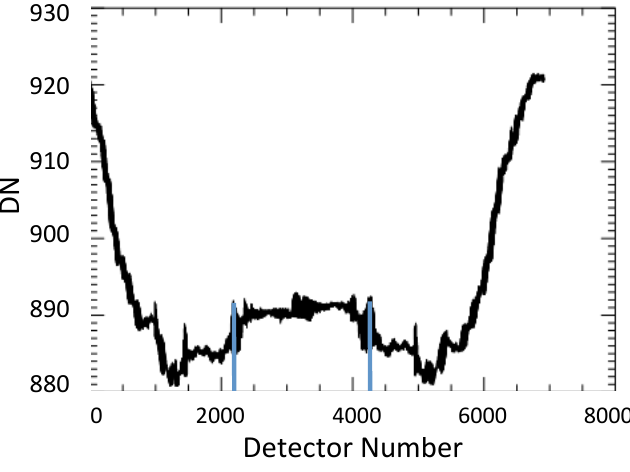
Figure 12. Column average of the mis-calibrated data shown in Figure 11(bottom). Note that although variability across the entire field-of-view is in excess of 4.5%, the variability in the center region (between blue lines) is less than